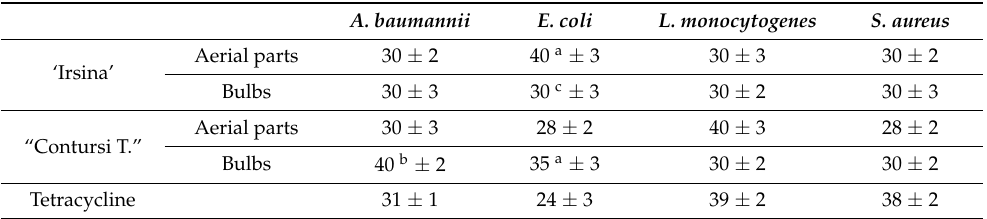
Table 4. Minimal inhibitory concentration ( µ L/mL) of the EOS from cultivars of A. ampeloprasum var. holmense necessary to inhibit the growth of the pathogenic bacterial strains Listeria monocytogenes , Escherichia coli , Acinetobacter baumannii , and Staphylococcus aureus .